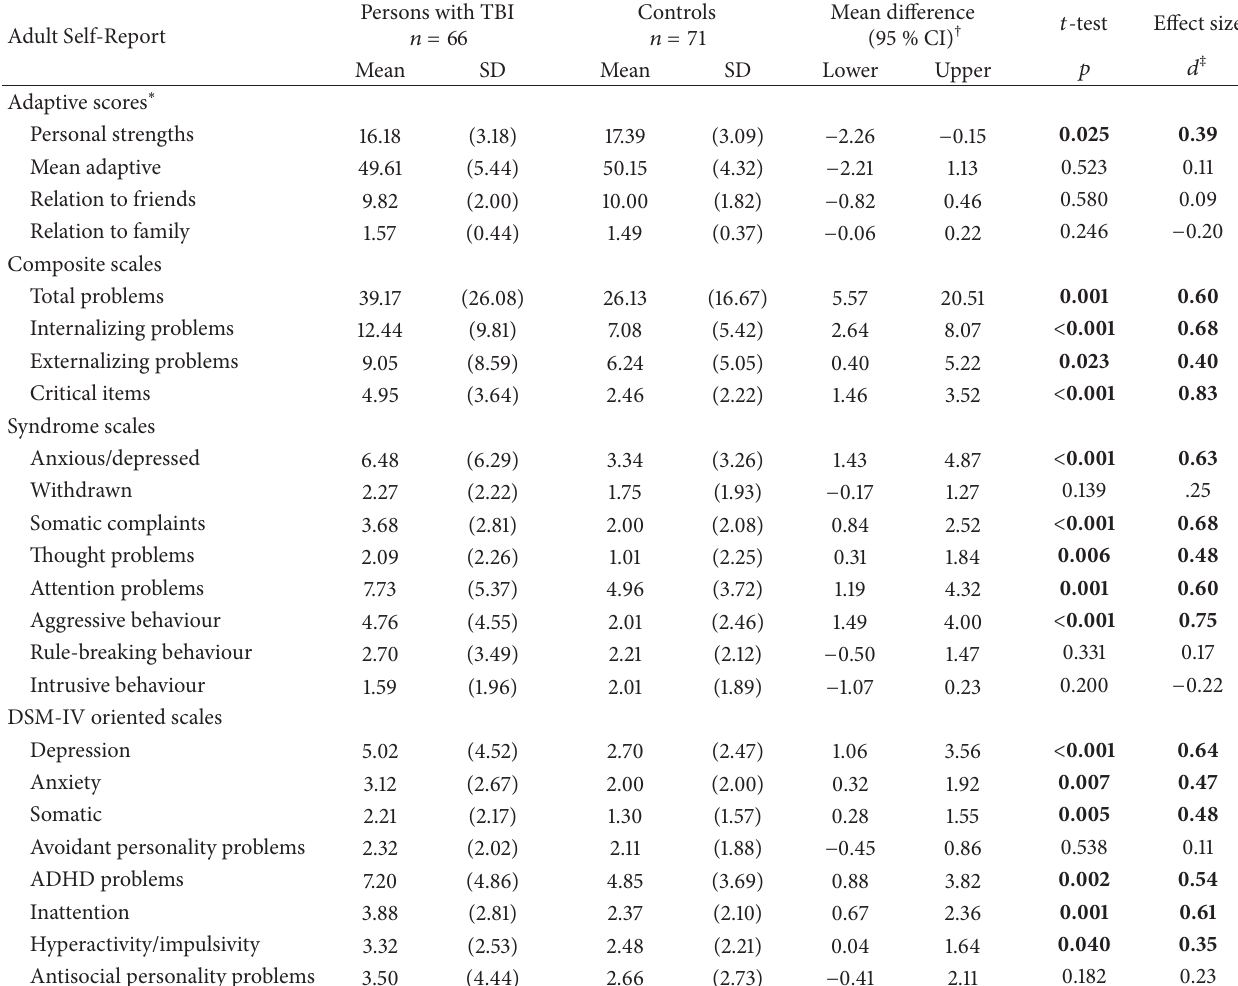
Table 4: Self-reported adaptive function, personal strengths, and psychological problems on ASR at 2–5 years after moderate and severe Traumatic Brain Injury compared to healthy